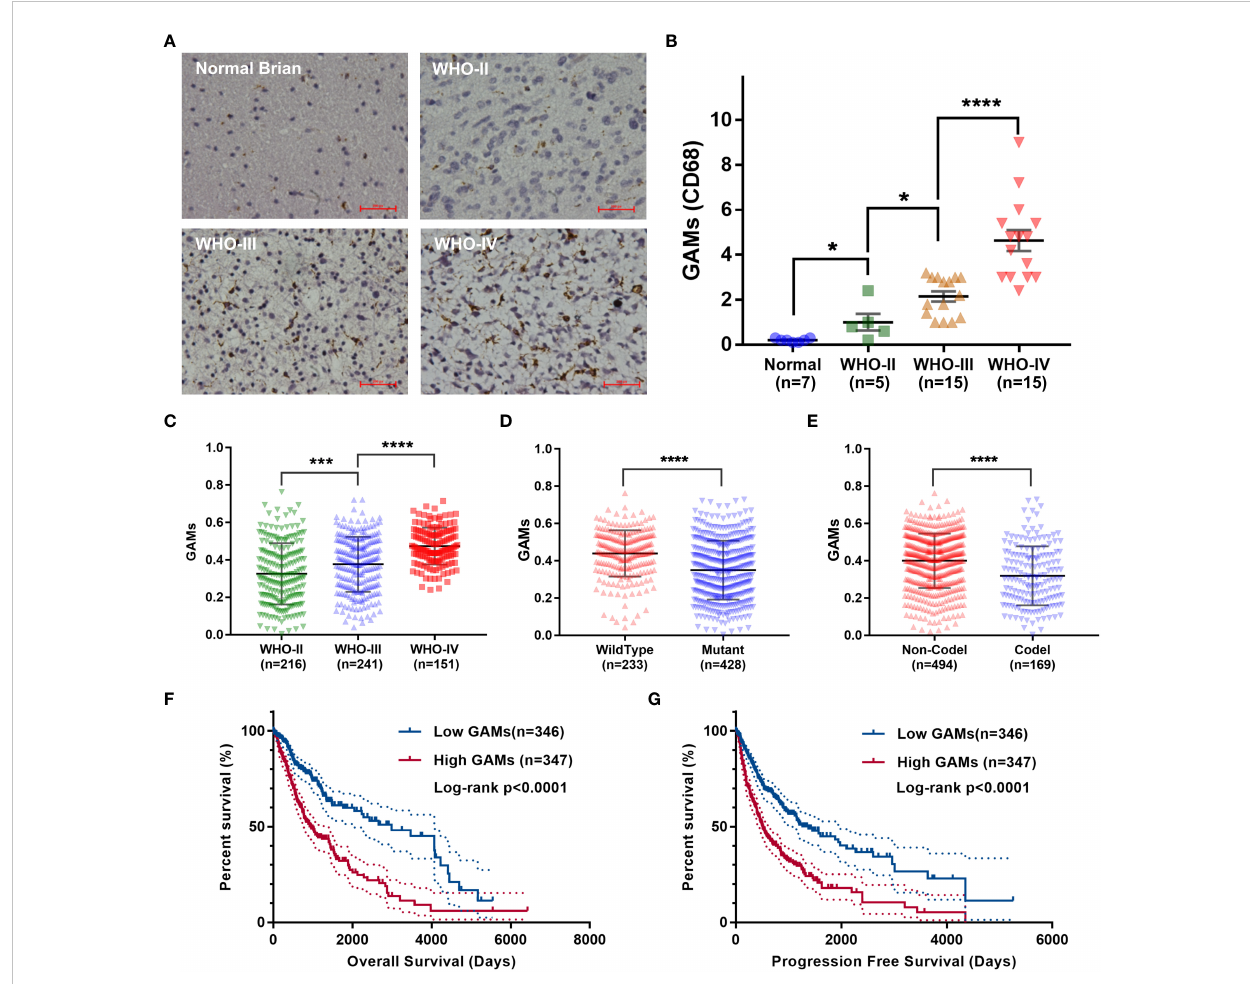
FIGURE 1 Analysis of correlation between the in fi ltration of GAMs and glioma malignancy. (A, B) . Detection of CD68 expression in normal brain tissues and glioma tissues with different malignant grades. The representative IHC of normal and glioma tissues (A) . The statistical graphs of GAMs (CD68 + ) (B) . (C-G) . Analysis of RNA-seq of glioma samples from the TCGA dataset. The levels of GAMs in gliomas with different WHO grades (C) , IDH mutation (D) , and 1p19q deletion (E) status. Correlation between the contents of GAMs and the overall survival (F) and progression-free survival (G) of glioma patients. (Scale bars represent 200 m m; * for p-value< 0.05; *** for p-value< 0.01; **** for p-value<